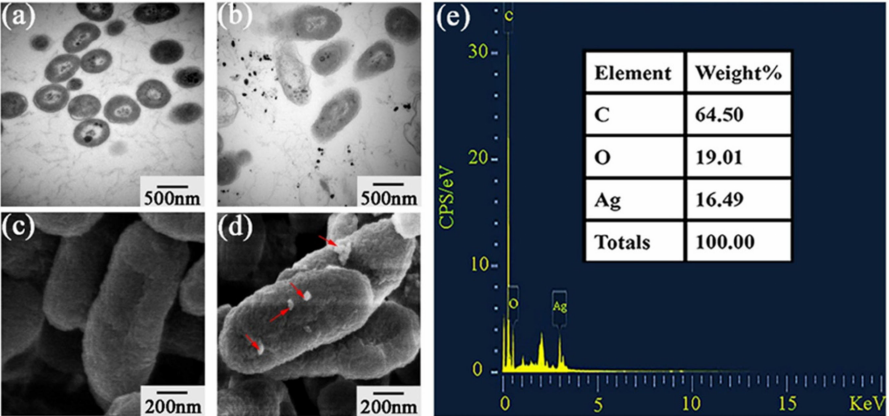
Figure 7. Ultrastructural observation of Xoo strain C2 after 24 h treatment with/without 20 µ g/mL Al-AgNPs. ( a ) TEM images of bacterial without Al-AgNPs. ( b ) TEM images of bacterial with Al- AgNPs. ( c ) SEM images of bacterial without Al-AgNPs. ( d ) SEM images of bacterial with Al-AgNPs. ( e ) EDS analysis of bacteria treated with